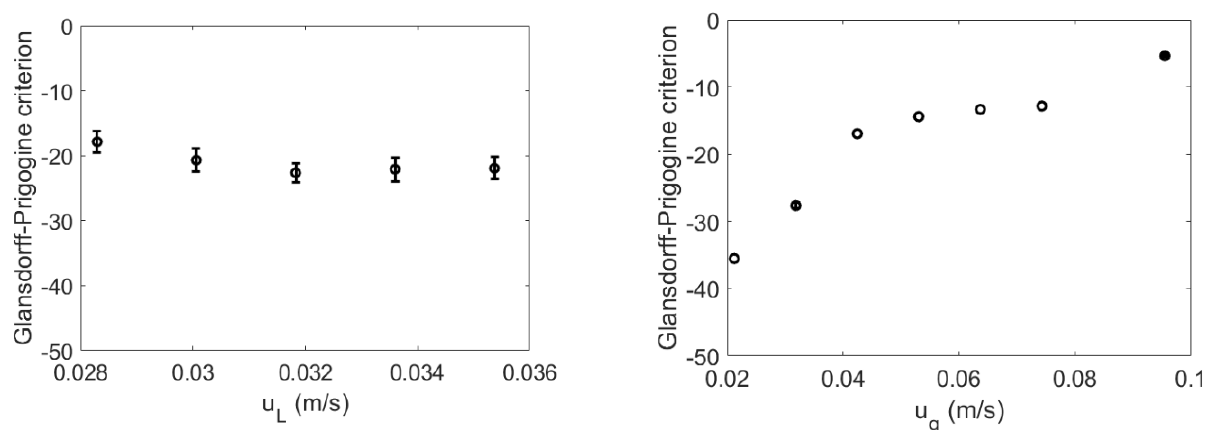
Figure 9. Fisher information variation during mixing time for the LSFB ( left ) and the GLSFB ( right ) systems.